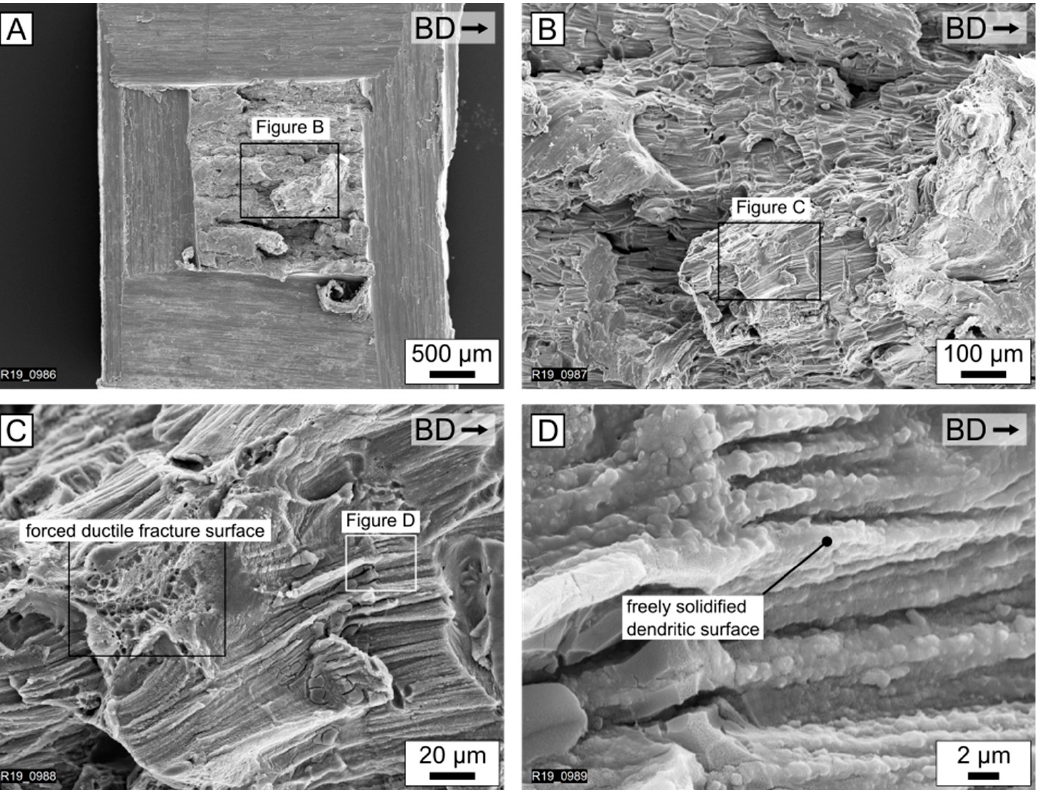
Figure 4. SEM images of the fracture surface of the base alloy EN AW ‐ 5083 (Al Mg4.5Mn0.7). ( A ) Indicating the procedure for the forced fracture in the laboratory, ( B ) magnification highlighting the melt pools, ( C ) magnification highlighting the forced ductile fracture surface and dendritic struc ‐ ture, and ( D ) magnification of freely ‐ solidified dendritic surface, typically for solidification cracks.